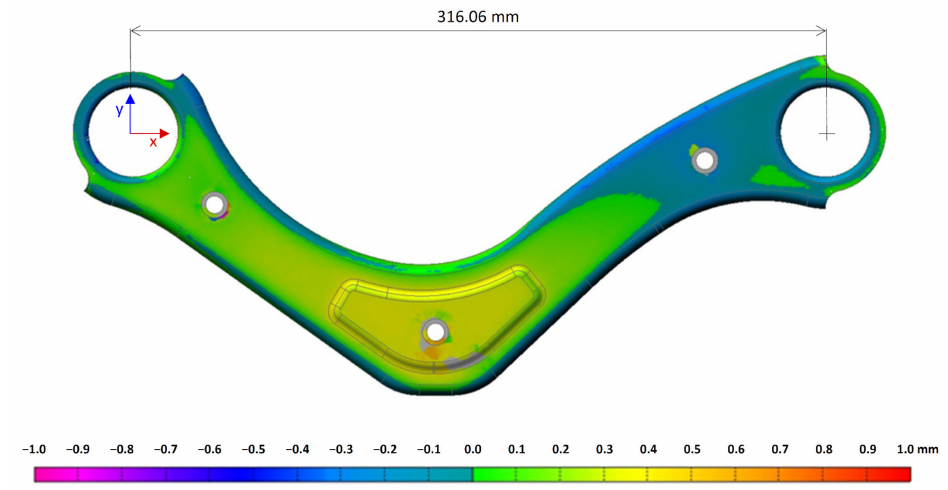
Figure 8. The total deviation of the stamped component from the 3D model.